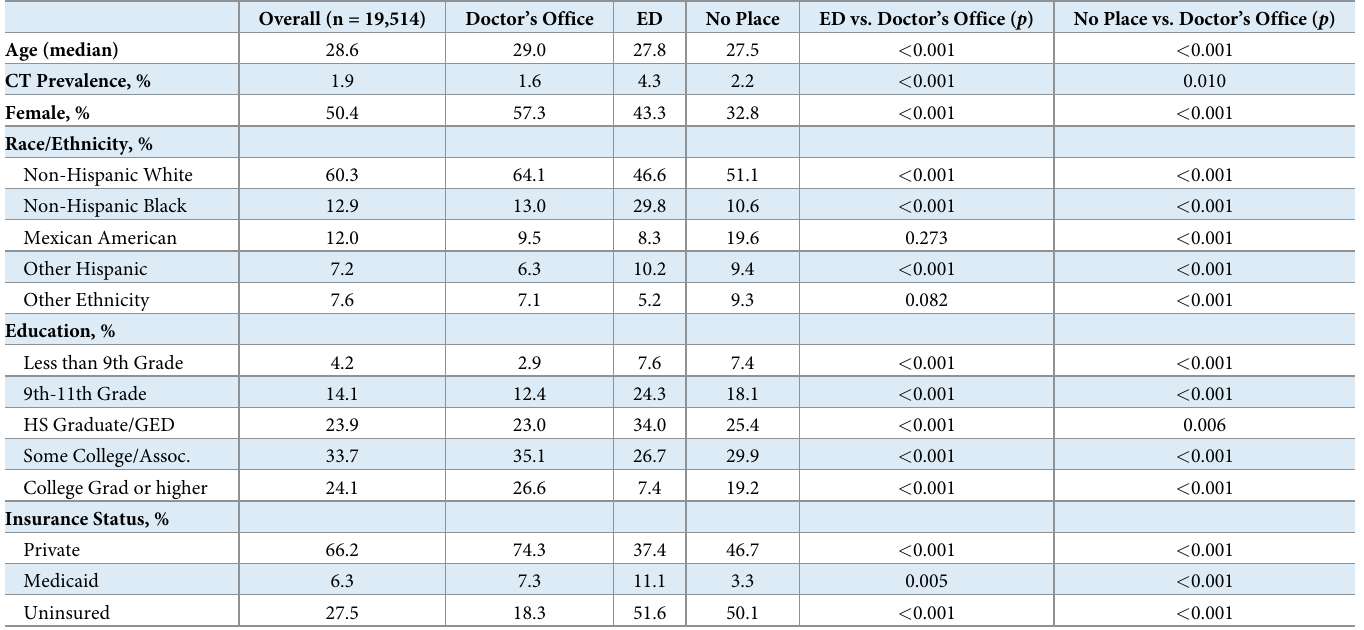
Table 1. Estimated population of sociodemographic characteristics among 18–39 years old by routine place for healthcare, NHANES, 1999 to 2016. Overall (n =